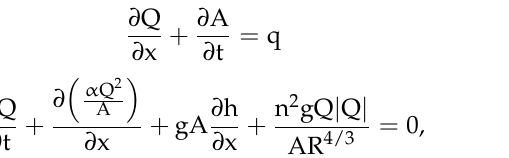
Figure 2. The geometries of Júcar River gauging stations are shown as introduced in the Cross Section file of MIKE11 for ( a ) El Picazo, ( b ) Puente Carrasco, ( c ) Los Frailes, and ( d ) Alcala del Júcar. Minimum and maximum water levels are indicated with green and red dashed lines, respectively, while intermediate water levels are drawn in blue. The rest of the cross sections with irregular geometries were also introduced but are not shown here. Their locations can be found on Figure 1.